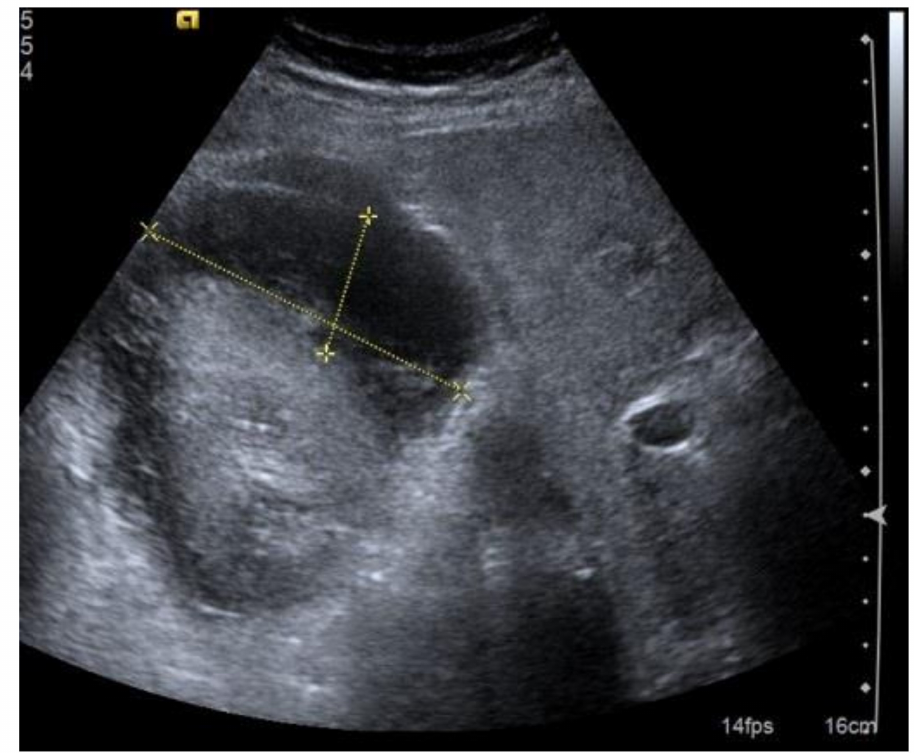
Figure 7. Extensive post-bioptic subcapsular hematoma; the anecogenicity of the effusion indicates that the bleeding is recent, but it is not possible to obtain reliable information as to whether bleeding still exists. Size is an unreliable parameter in these cases. In the presence of post-biopsy hematoma, non-invasive dynamic contrast studies (CEUS or contrast-enhanced CT) can be very useful to evaluate a bleeding source and any rarer post-biopsy vascular